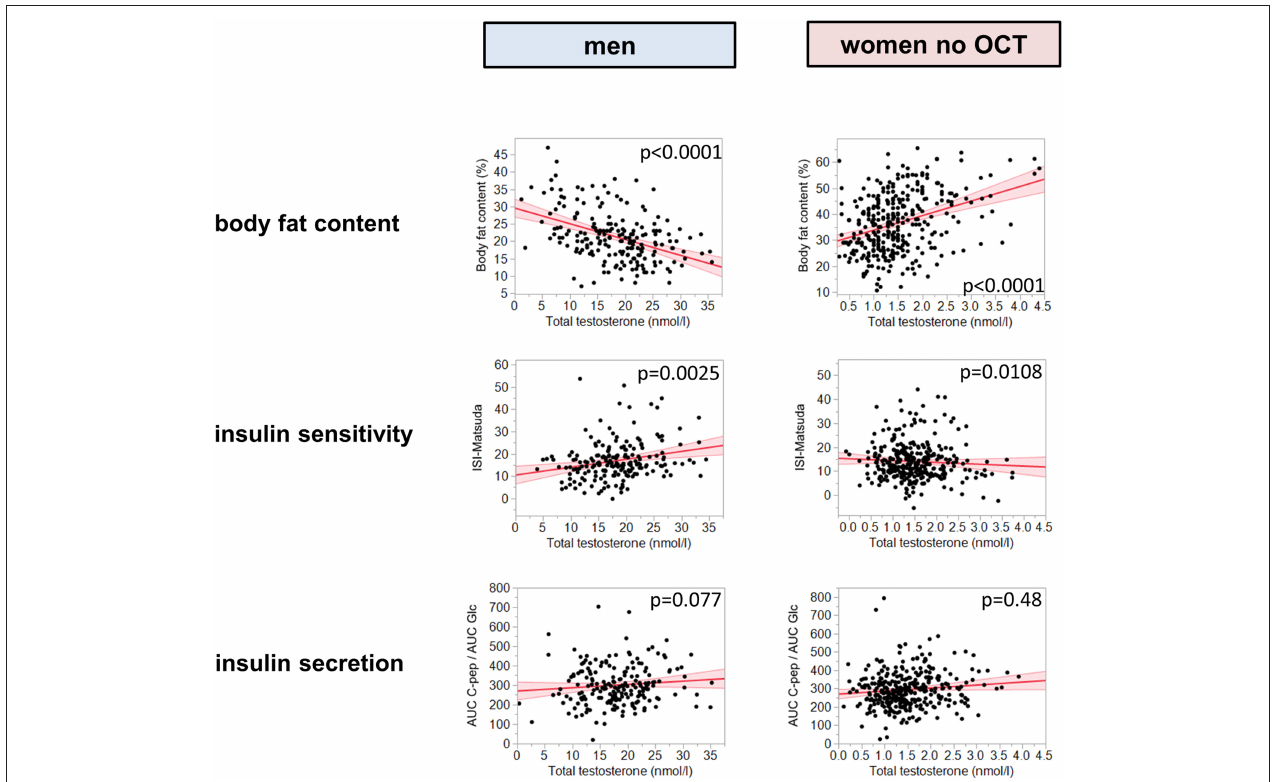
FIGURE 1 | Presented are metabolic traits plotted against testosterone. The left column presents results for total testosterone in men, the right column presents total testosterone in women without OCT. The first line reports body fat content, the second insulin sensitivity, and the third insulin secretion, assessed as AUC C-peptide/AUC glucose. Red line represents fit line ± 95% CI. Associations were tested by multiple linear regression analyses of log-transformed data. Insulin sensitivity was adjusted for body fat content and age, insulin secretion was adjusted for age and insulin sensitivity. OCT, oral contraceptive